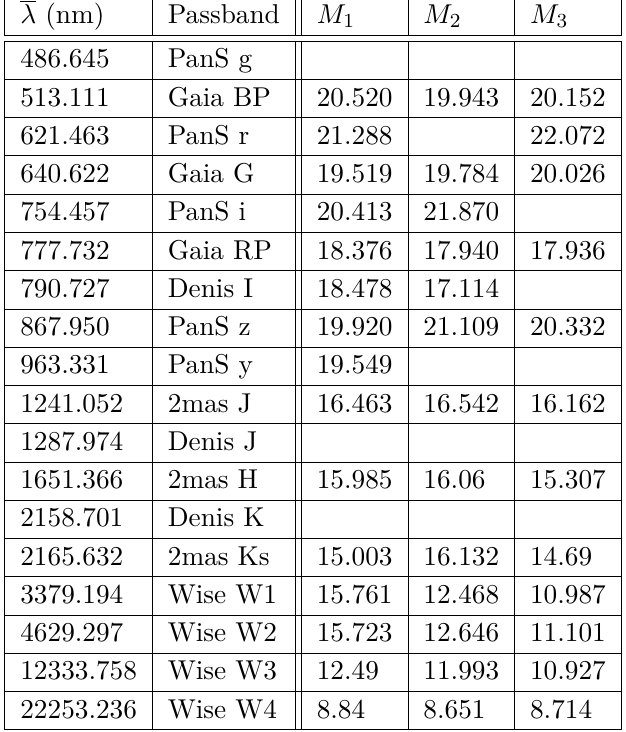
Table 2. Absolute magnitudes M 1 , 2 , 3 of our three mirror star candidates in the passbands of the surveys we used. Blank fields indicate no data